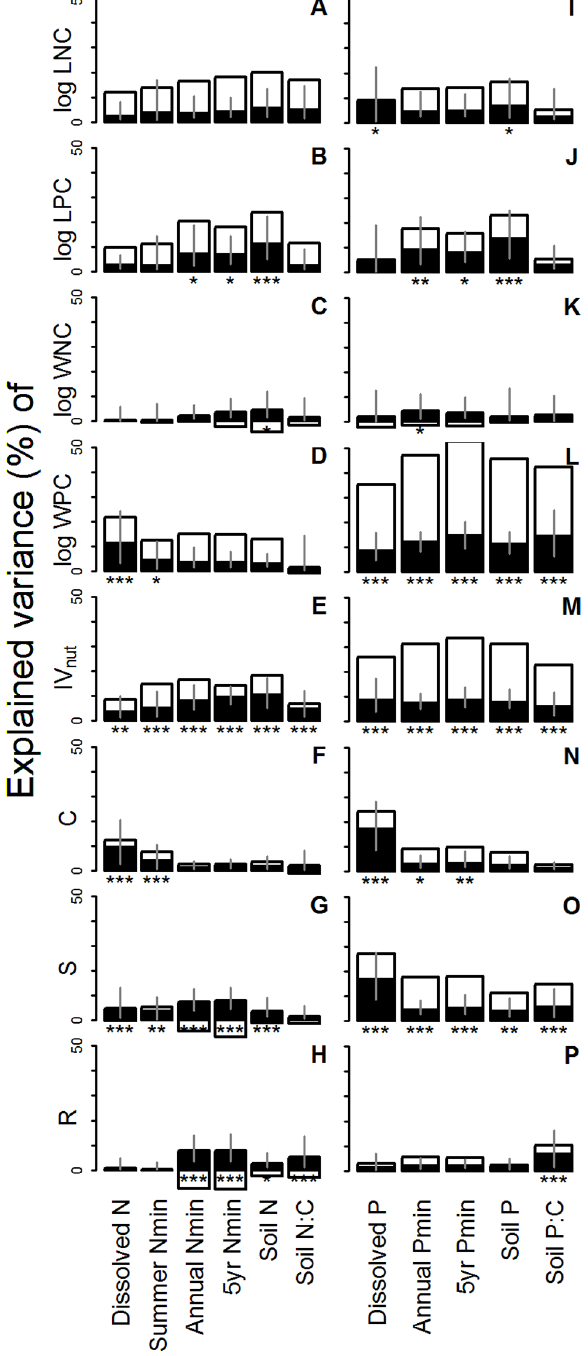
Figure 2. Hierarchical partitioning of among-site plant trait variation. Trait variations are divided into independent effects of a soil fertility measure (black bars) and its joint effects with other measures (white bars). All fertility measures (see Table 1 for specification) were log-transformed prior to the analysis. Examined plot-mean plant traits are A&I: log LNC, B&J: log LPC, C&K: log WNC, D&L: log WPC, E&M: IV nut , F&N: C component, G&O: S component, and H&P: R component. See the caption of Figure 1 for the specification and sample number of each plant trait. Computation was done within each group of fertility measures (i.e. within soil N measures [A–H] and soil P measures [I–P]). Asterisks indicate that the independent effect was significant, based on Z-scores computed with randomization ( * : p , 0.05, ** : p , 0.01, ***